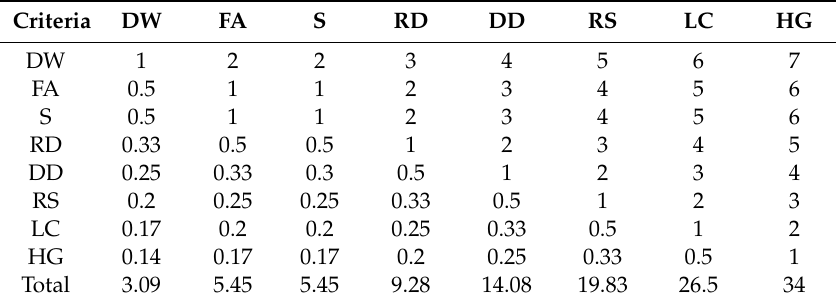
Table 5. Pairwise comparison matrix for factor